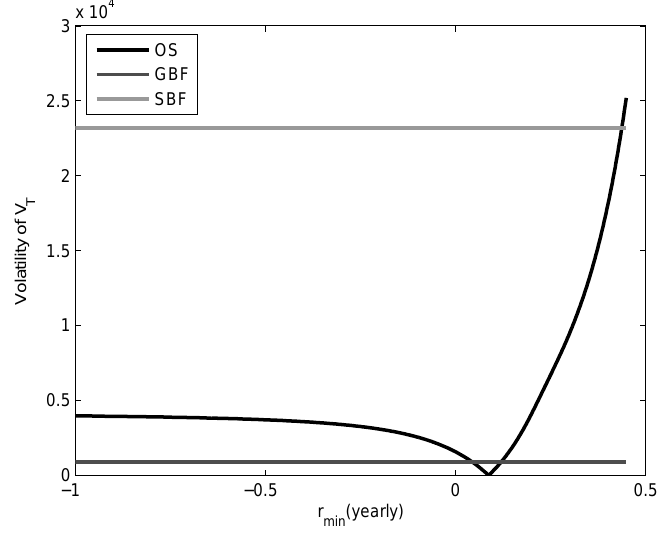
Figure 1. Volatility of the value of the pension funds at maturity under optimal strategy (OS) for various r min ( σ = 0.015).